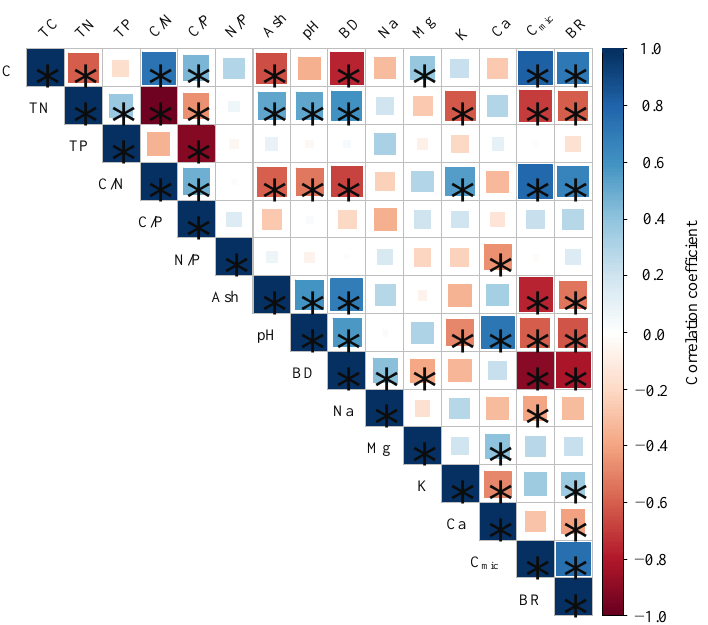
Figure 3. Relationship between soil basal respiration rates (BR) and soil properties (TC: total carbon concentration, TN: total nitrogen concentration, TP: total phosphors concentration, C/N: carbon to nitrogen ratio, C/P: carbon to phosphors ration, Ash: ash content, pH: pH value, BD: bulk density, Na: sodium concentration, Mg: magnesium concentration, K: potassium concentration, Ca: calcium concentration, C mic : microbial biomass carbon, C mic /C org : microbial entropy, BR: basal respiration rate, and qCO 2 : metabolic entropy). Significant ( p < 0.05) correlation coefficients after Spearman (significant correlations ( p < 0.05) are marked with asterisks.